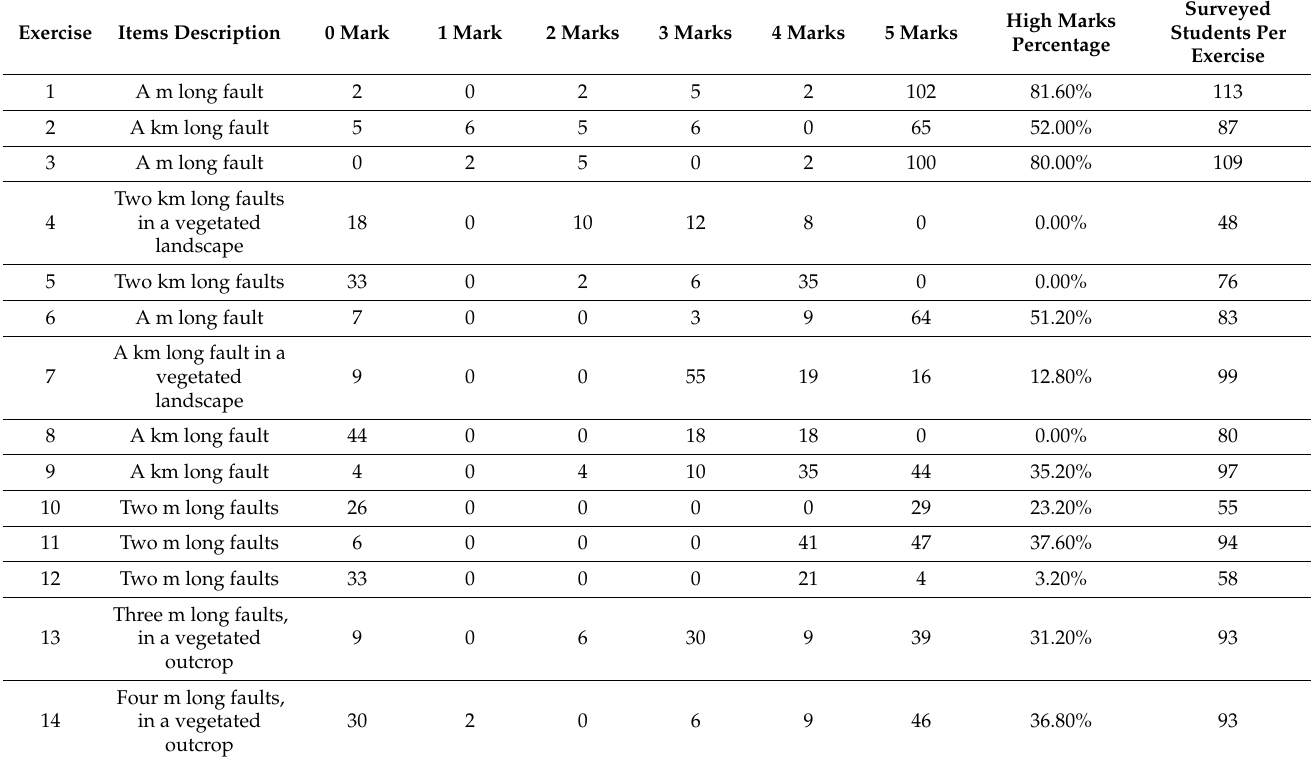
Table 4. Summary of the answers of the students corresponding to each image and the